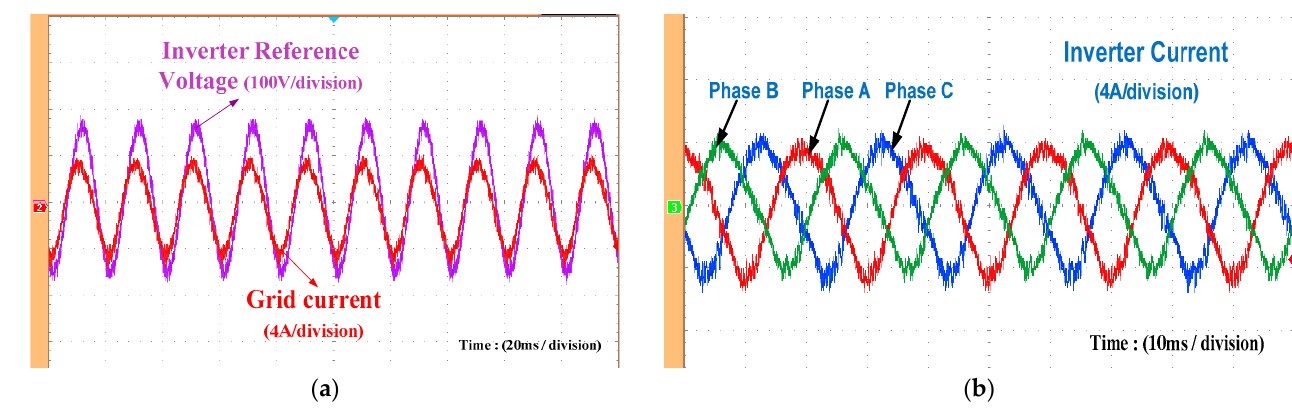
Figure 14. ( a ) Grid current and inverter reference voltage with unity power factor; ( b ) three phase inverter current for 934 W power delivery.